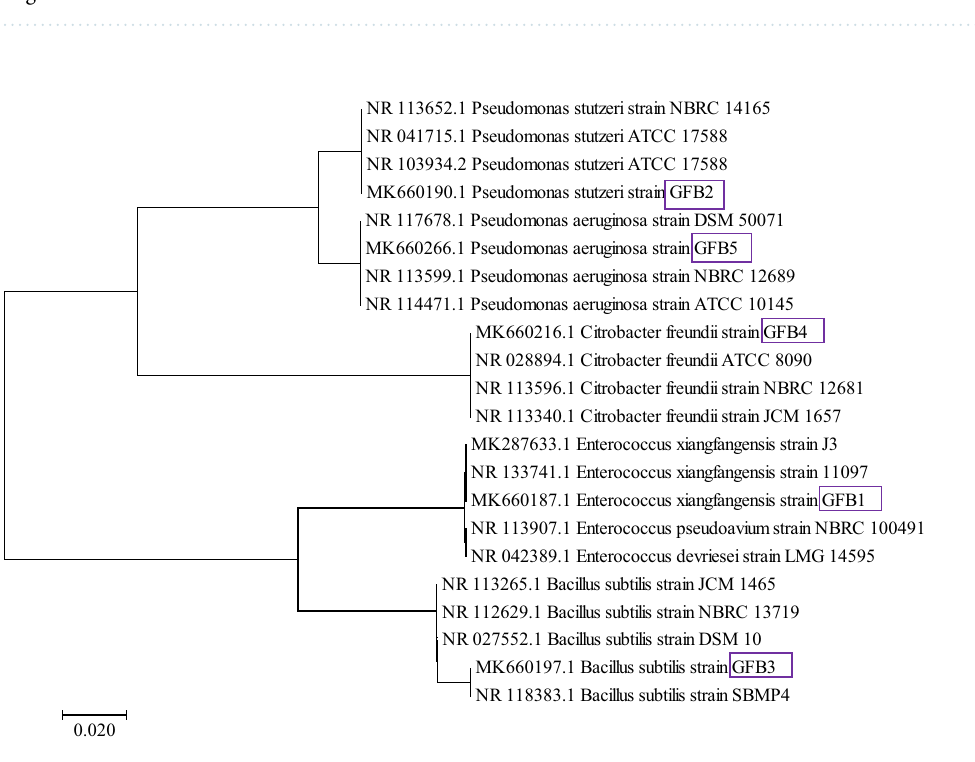
Figure 1. Phylogenetic relationship of strain GFB-1 (MK660187.1), GFB-2 (MK660190.1), GFB-3 (MK660197.1), GFB-4 (MK660216.1) and GFB-5 (MK660266.1) with their corresponding genus. The evolutionary distances were computed using the Maximum Composite Likelihood method. Evolutionary analyses were conducted in